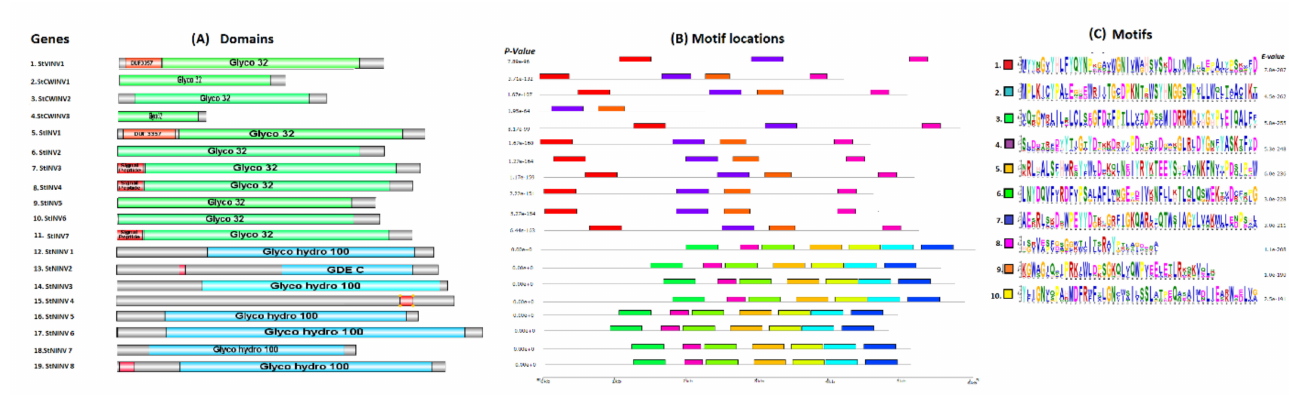
Figure 5. Graphical representation of functional domain and motifs. ( A ) Represents function domain on genes. ( B ) Shows different motifs located on the genes. ( C ) Motifs found by meme